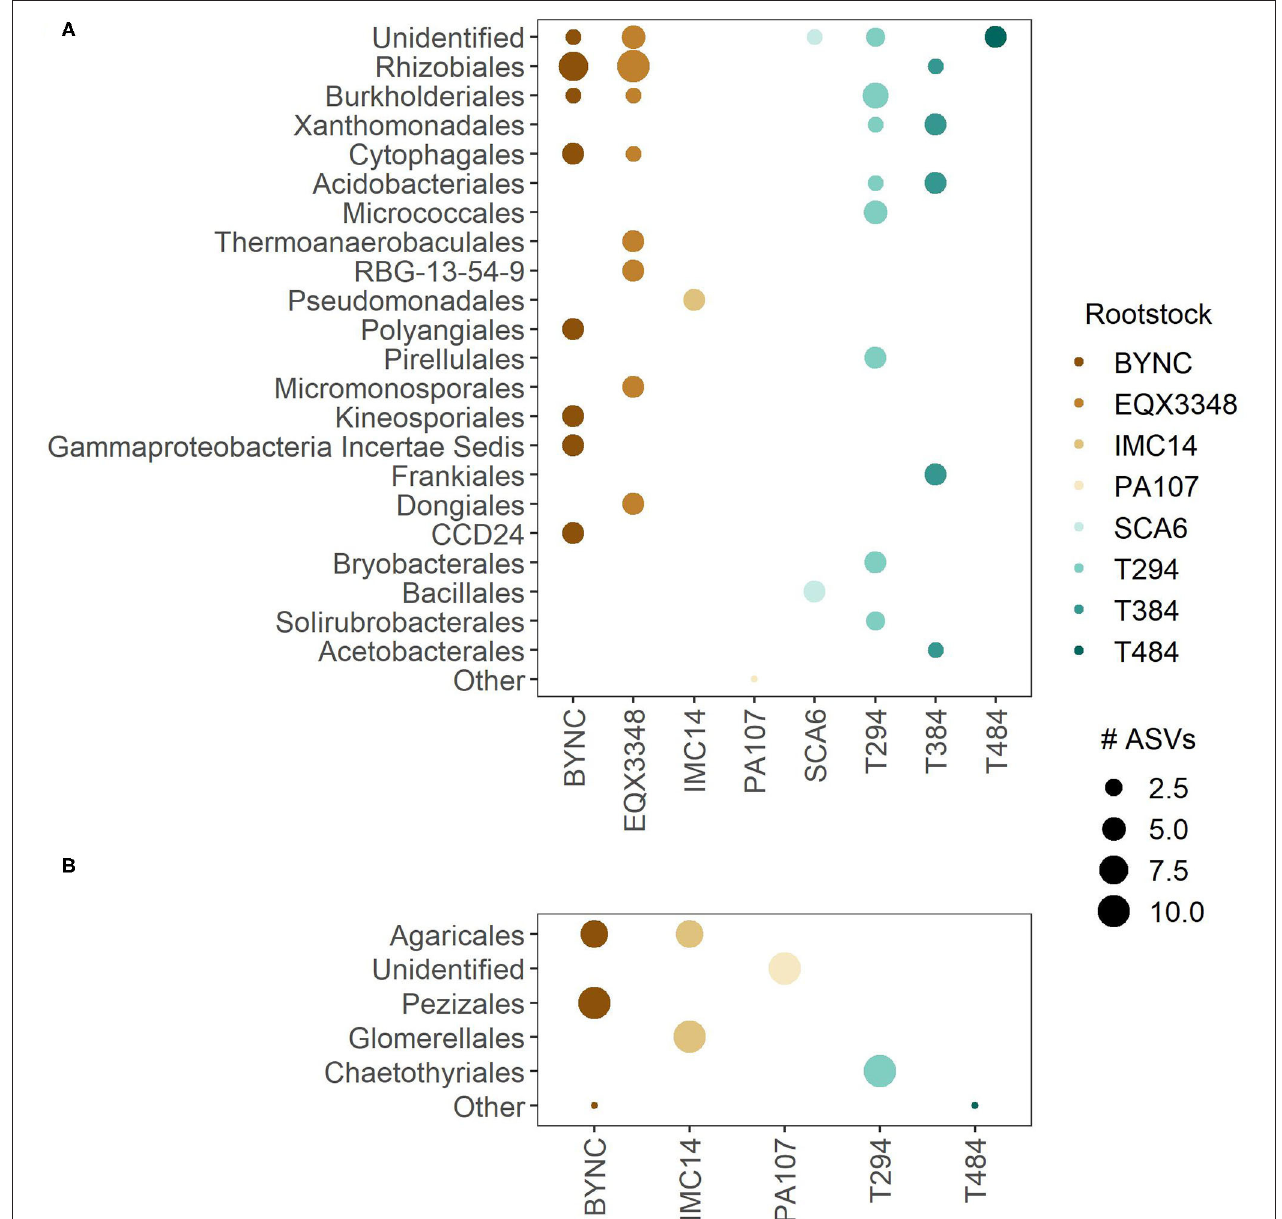
FIGURE 5 | Distribution of rootstock-responsive taxa with potential impacts on plant nutrition. The linear discriminant analysis effect size (LEfSe) method identified (A) bacteria and (B) fungi responsible for differentiation among rootstocks (LDA > 2, p < 0.05). To focus the analysis on taxa potentially relevant for plant nutrition, LEfSe was applied to bacterial and fungal amplicon sequence variants (ASVs) with the highest loadings on the first two eigenvectors used in leaf nutrient models (PC1B, PC2B, PC1F, and PC2F in Figure 4 ). ASVs are identified to order and classified as “Unidentified” if only higher taxonomic levels were available. “Other” is used to represent orders with fewer than three members. Dots represent the number of ASVs from a given order whose relative abundance was enriched in one